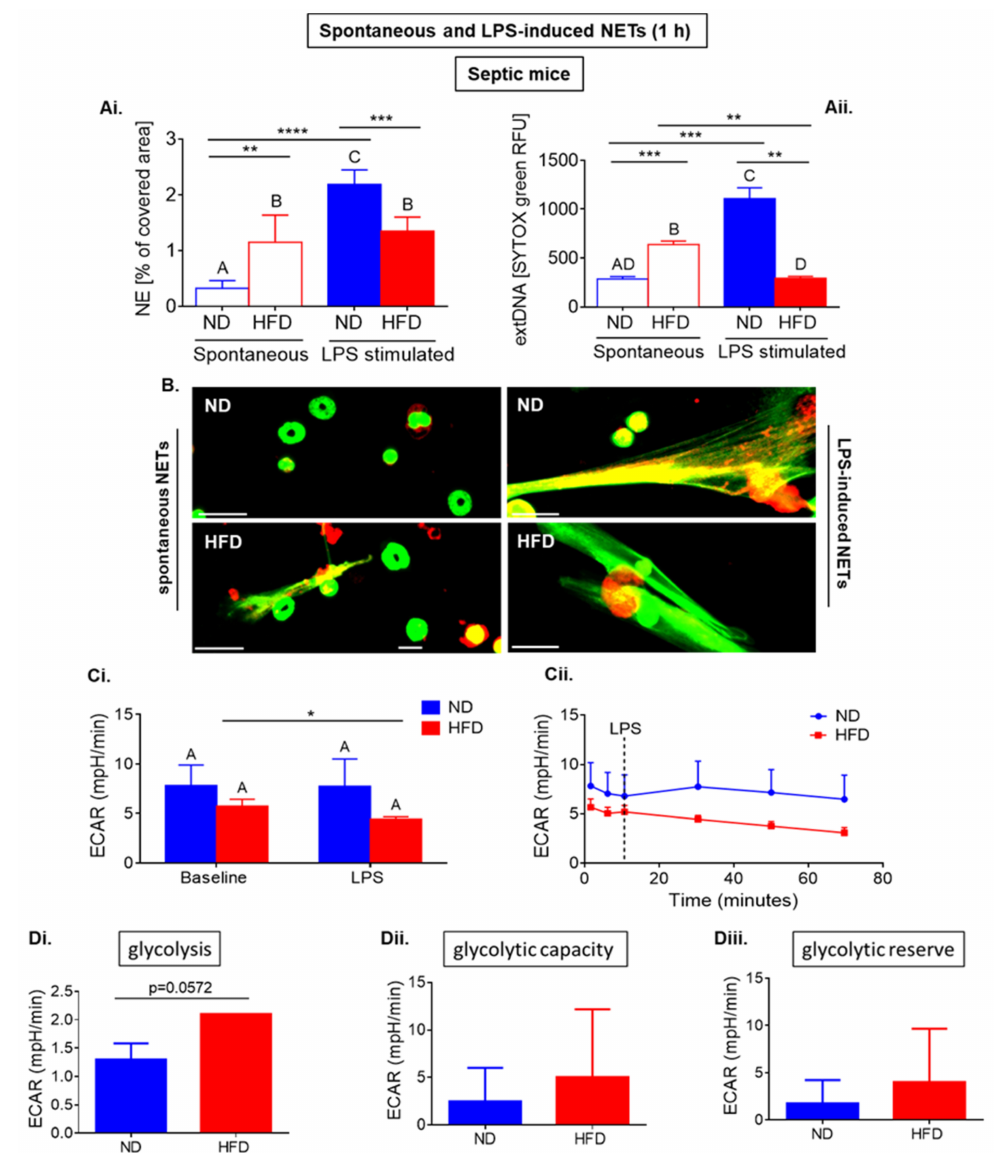
Figure 2. Short-term formation of neutrophil extracellular traps (NETs), and metabolic parameters of neutrophils iso- lated from septic mice with obesity induced by high fat diet (HFD) and their lean controls (ND). Systemic inflamma- tion/endotoxemia was induced 24 h prior to neutrophil isolation by injecting animals with 1 mg/kg body weight of lipopolysaccharide (LPS). NET formation and metabolic parameters were measured within one hour since cell seeding or ex vivo activation with LPS. NETs were quantified upon staining of neutrophil elastase (NE, ImageJ software) ( Ai ), and ( Aii ) extracellular DNA (extDNA) with SYTOX green; fluorescent signal was quantified using a microplate reader (relative fluorescence units, RFU); ( B ) representative images of NETs are presented for spontaneous NETs of ND and HFD mice and for NETs induced with lipopolysaccharide (LPS). NETs were detected by immunocytochemical counterstaining of neutrophil elastase (NE, red) along with extracellular DNA (extDNA, green). Scale bars indicate: 25 µ m. Metabolic parameters were measured with a Seahorse analyzer ( C , D ). Data quantification of Extracellular Acidification Rate (ECAR) ( Ci ) and a representative Seahorse readout ( Cii ) are presented. ( D ) Glycolysis Stress Test was used to establish glycolysis rate ( Di ), glycolysis capacity ( Dii ), and glycolytic reserve ( Diii ). Asterisks indicate significant differences between groups according to unpaired two-tailed Student’s t -test (* p ≤ 0.05, ** p ≤ 0.01, *** p ≤ 0.001, **** p ≤ 0.0001). Results of one-way ANOVA (post hoc Bonferroni): any two means that do not share same letter are significantly different. Data are shown as mean ± s.d.; n ≥ 3 per